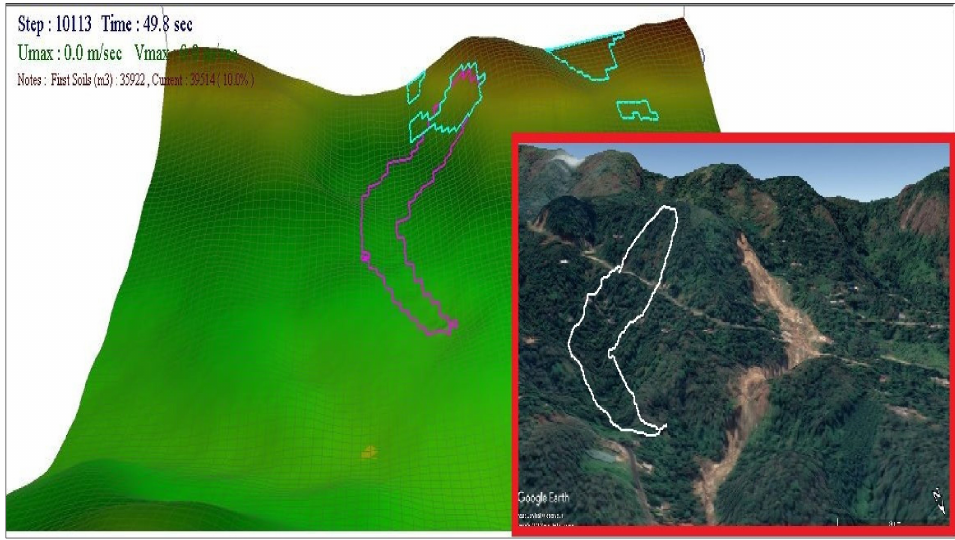
Figure 17. Simulation results of the probable landslide area analyzed in